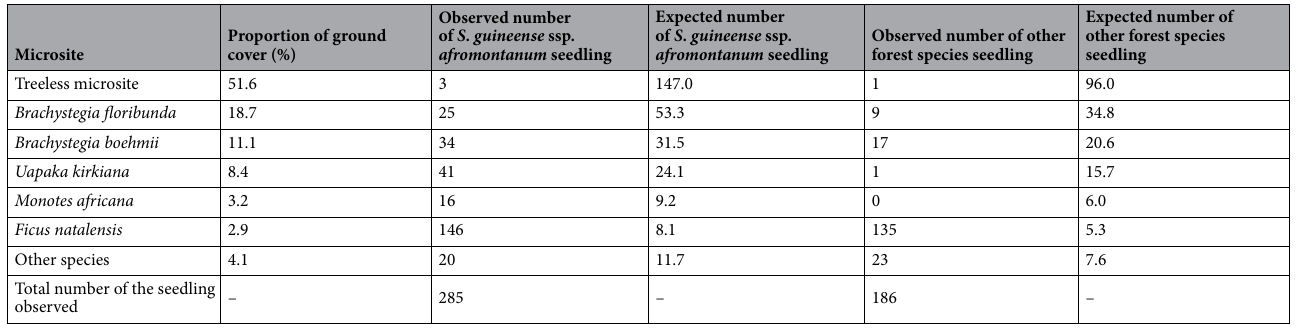
Table 1. Spatial association between microsites and Syzygium guineense ssp. afromontanum and other forest species seedling in miombo woodland in northern